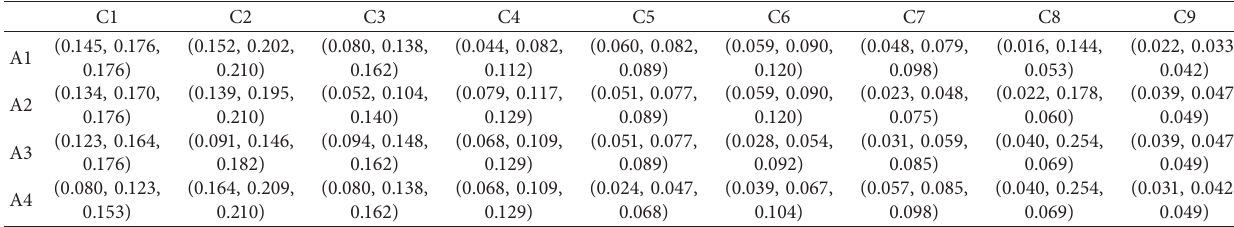
Table 12: Weighted normalized fuzzy decision matrix 􏽥 V .